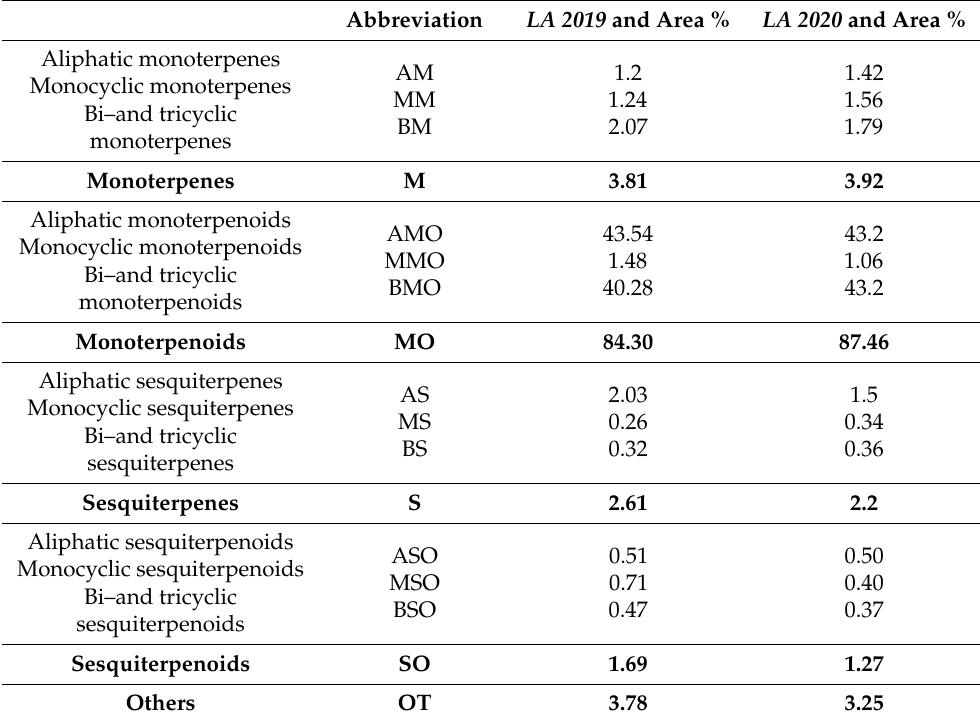
Figure 1. The GC-MS TIC chromatograms of the LA 2019 and LA 2020 samples. Numbers refer to those reported in Table 1. Table 2. List of terpenes in the lavender